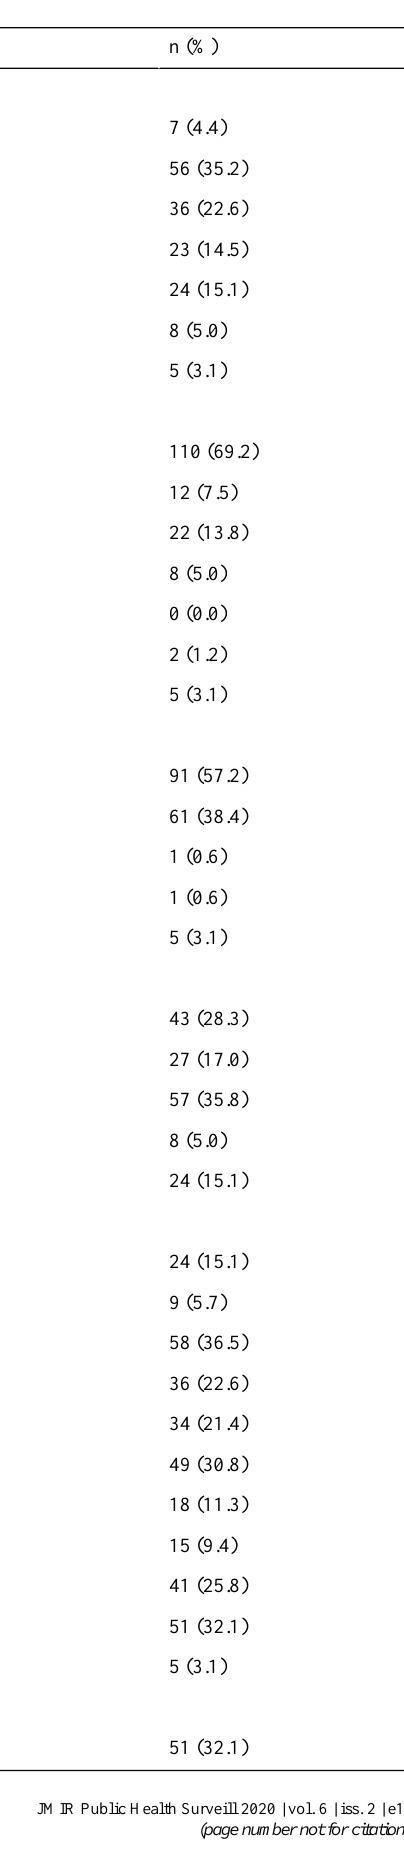
Table 1. Characteristics of the iCollect pilot study participants